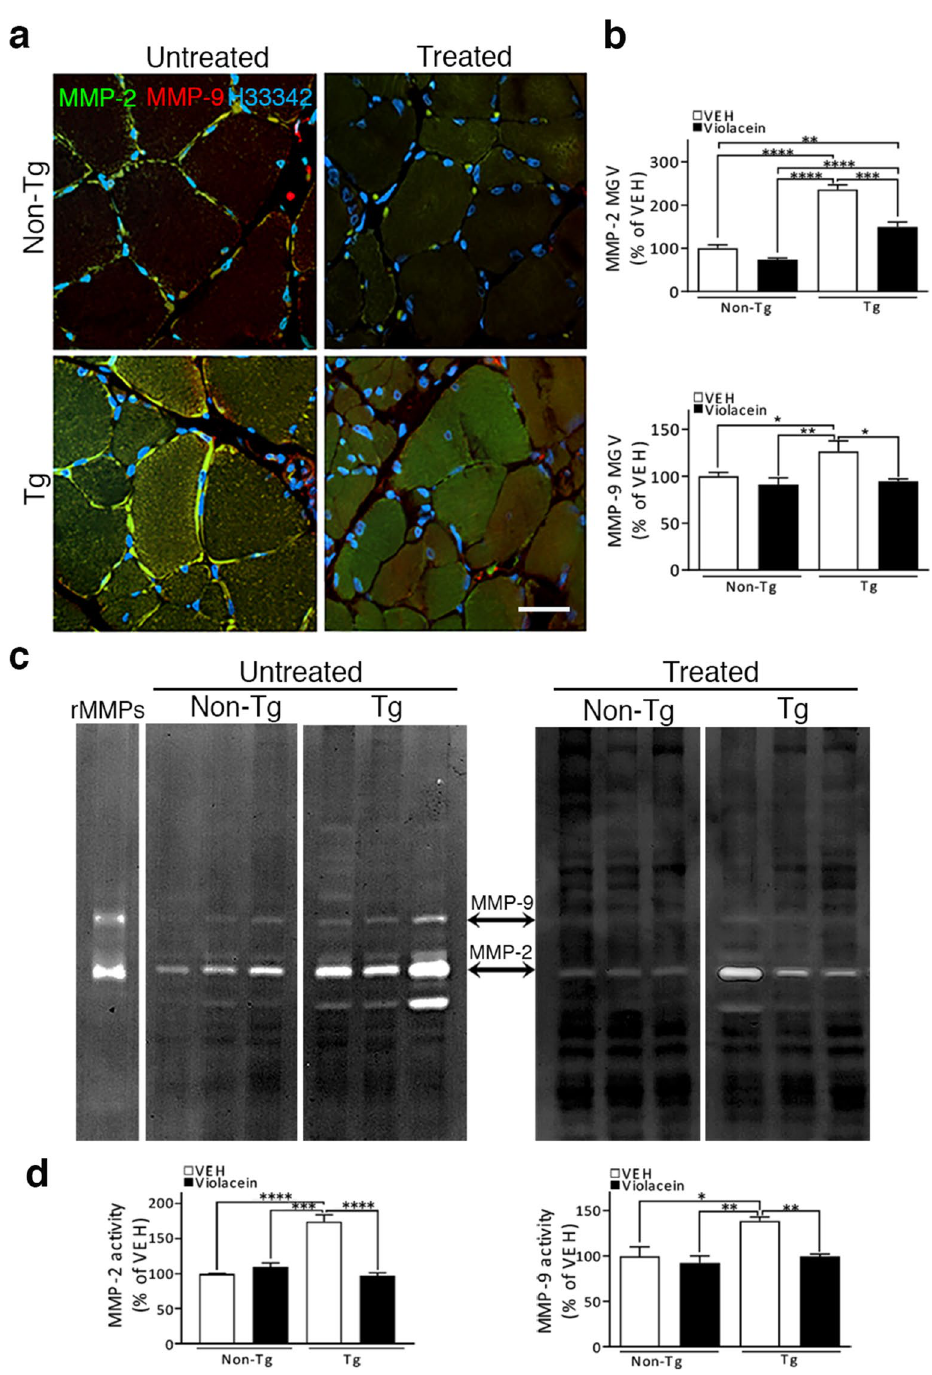
Figure 5. Violacein inhibited muscle MMP-2 and -9. ( a ) Representative confocal immunofluorescences of soleus muscle transverse sections labelled against MMP-2 (green) and MMP-9 (red). Non-Tg muscles showed positive signals associated to the sarcolemma. The same location but increased signal appeared in the Tg-untreated muscle together with a punctate expression in the sarcoplasm. Instead, Tg-treated sections showed low signals associated to the sarcolemma plus a heterogeneous staining in the sarcoplasm with more atrophic fibers enriched in MMP-9 (red). Cell nuclei were labelled with Hoescht 33342. Calibration: 20 µm. ( b ) Quantitation of violacein inhibitory effects on MMP-2 and -9 immunoreactivity assessed by MGV. Upper chart indicates that MMP-2 increased in Tg-untreated (~ 130%, p < 0.0001) and –treated (~ 80%, p < 0.0001) versus Non-Tg samples. MMP-9 (bottom chart) was increased in Tg-untreated versus Non-Tg samples (~ 50%, p = 0.0455), but had similar values in Tg-treated and Non-Tg samples (p = 0.09). ( c ) Gel zymograms showing MMP-2 and MMP-9 gelatinolytic activities in soleus homogenates from 3 Non-Tg and 3 Tg animals that received vehicle (-untreated, left zymogram) or violacein (-treated, right zymogram). Note that violacein decreased both gelatinase signals. On the left appears an isolated lane showing the zymogram of the controls (recombinant MMP-2 and -9) that were ran in each gel. ( d ) Quantitation of violacein inhibitory effects of MMP -2 and -9 activities. Left chart shows increased MMP-2 activity when comparing Tg-untreated with either Non-Tg (p < 0.0001) or Tg-treated (p = 0.0003) samples. Tg-treated and Non-Tg homogenates showed similar MMP-2 activity (p = 0.7025). Right chart shows the increased MMP-9 activity in Tg-untreated versus Non-Tg (p = 0.0128) or versus Tg-treated (p = 0.0072) samples. Non-Tg and Tg-treated samples showed similar values (p =